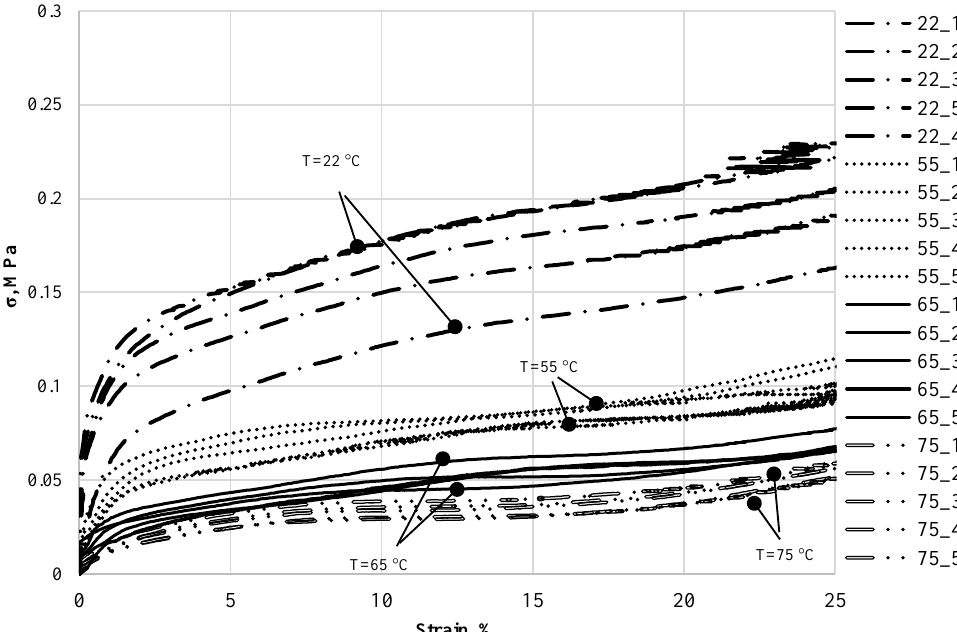
Fig. 3. Stress vs Strain curves for the tested PLA foam samples under different T